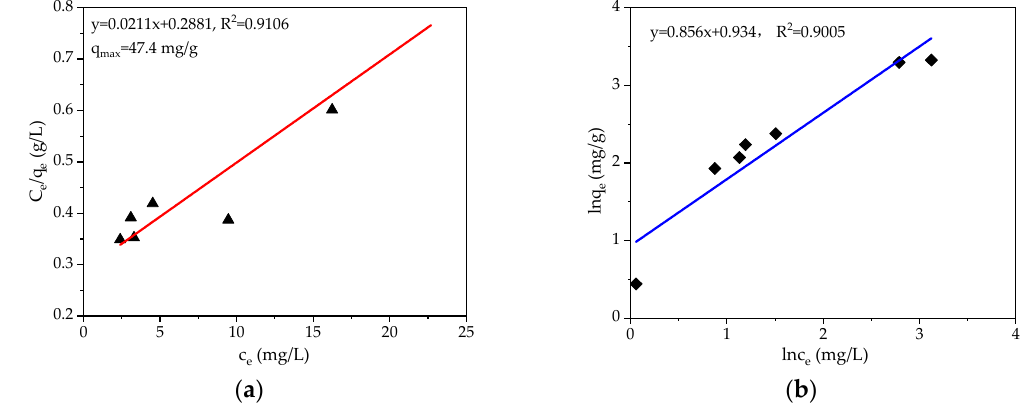
Figure 6. Adsorption isotherms of MB by gelatin/ β -CD composite fiber adsorbents: Langmuir isotherm ( a ) and Freundlich isotherm ( b ).